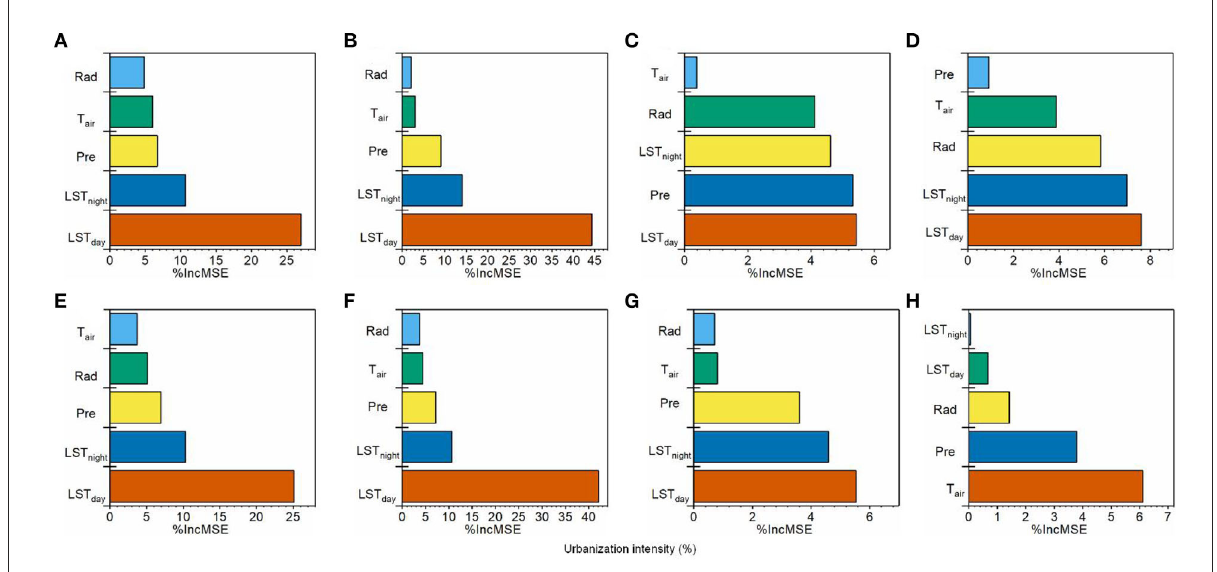
FIGURE6 The relative importance of climatic factors to indirect impacts of urbanization on GPP max and EVI max for the study area (A,E) , forest (B,F) , grassland (C,G) , and wetland (D,H) in 2020. LST day , land surface temperature of the day; LST night , land surface temperature of the night; Pre, annual precipitation; Tair, mean annual air temperature; Rad, solar radiation. The values were signed by the percentage increase of mean squared error (%IncMSE) in the RF model.